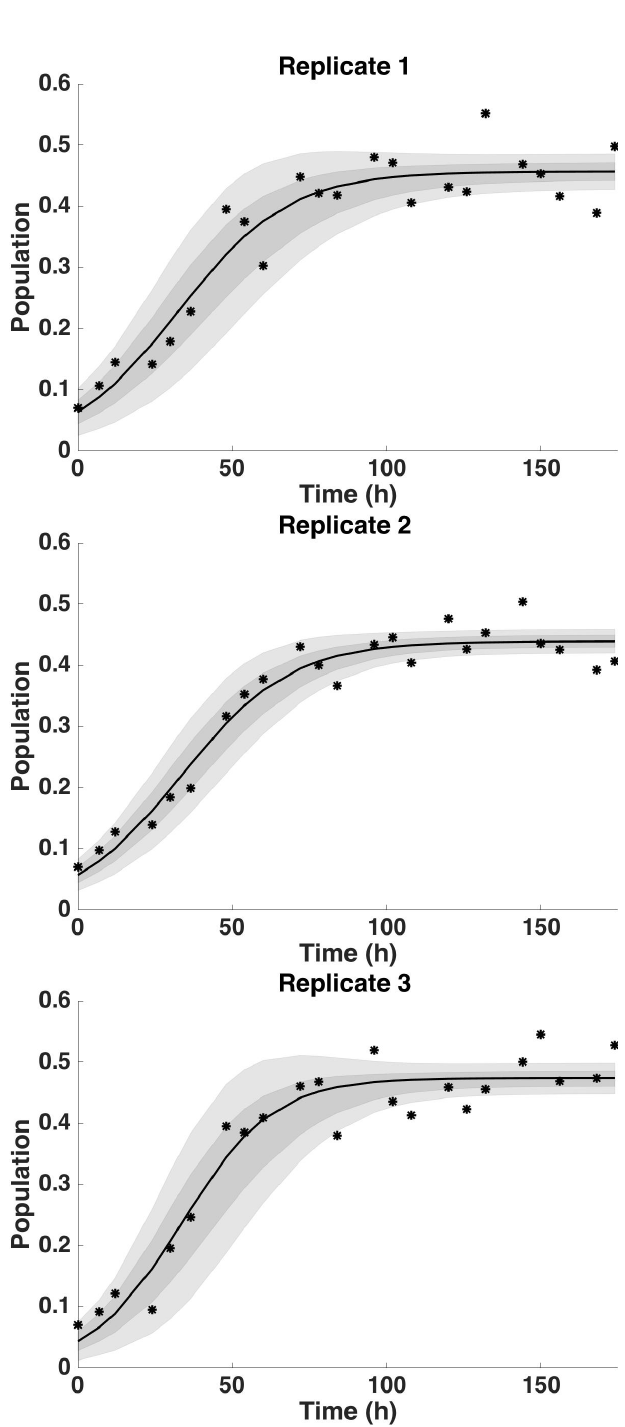
Figure 1. Plots of forward solutions for the Logistic curve for the three replicates of the data. Replicate one is on top and three is on the bottom. The lighter and darker shades of grey represent the 95% and 68% confidence bars on the model solution, respectively. The algae population is represented as cells × 10 7 /L. Data points are shown as